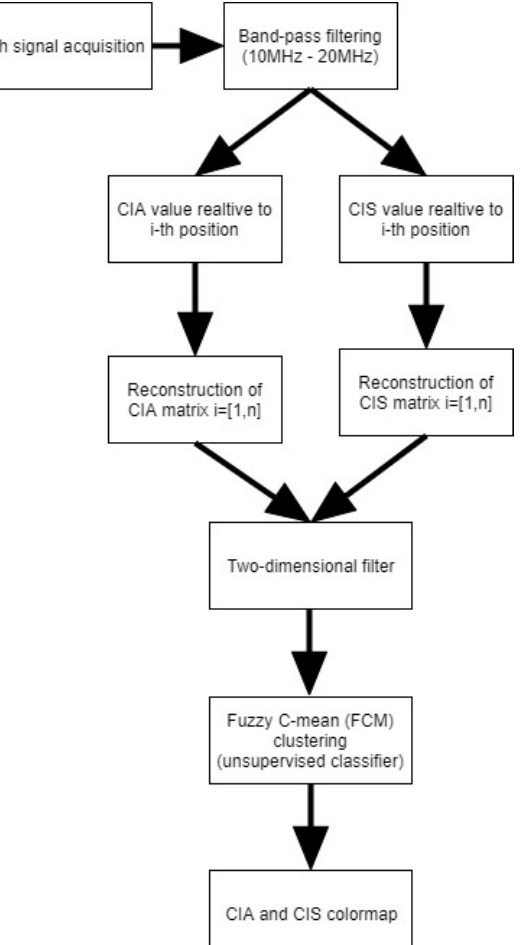
Figure 4. Flow-chart relative to Correlation Index Amplitude (CIA) and Correlation Index Shape (CIS) processing for the ultrasonic signal.